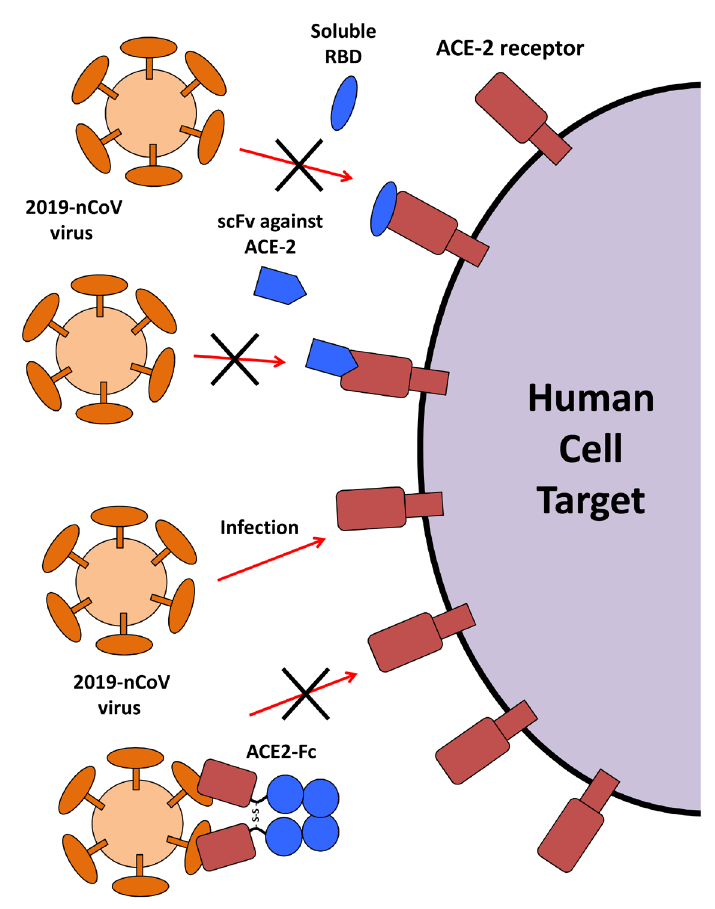
Figure 1. Therapeutic agents that could be used to block 2019-nCoV from infecting cells. Target cells expressing ACE2 include lung and gastrointestinal tissues in the human body. The large spike protein on the surface of the coronavirus binds to ACE2 on infected cells, leading to cell entry. Three proposed strategies would block this interaction would abrogate infection. In the first, the receptor-binding domain (RBD) of the spike protein from SARS or 2019-nCoV would be administered, thereby binding ACE2 and saturating available sites. Alternatively, an antibody or single chain antibody fragment (scFv) could be administered against ACE2 to accomplish the same. A third strategy would target the coronavirus virions directly by using the ACE2 extracellular domain as bait to bind to spike protein. An Fc domain fused to ACE2 would facilitate prolonged circulation of the biologic